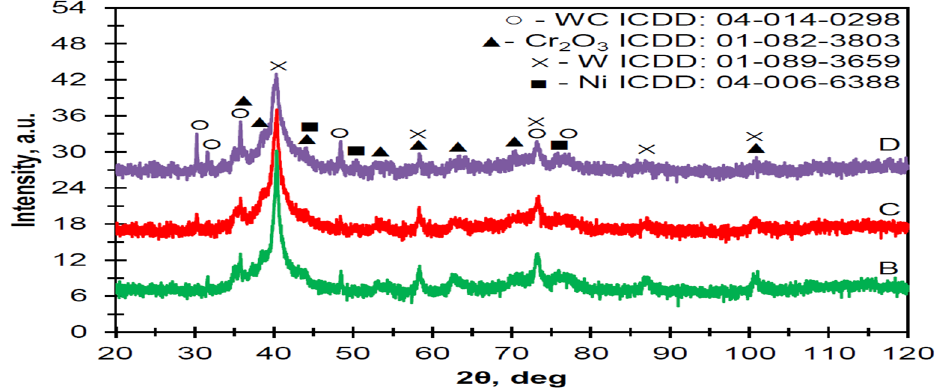
Figure 8. The XRD pattern of pure plasma-sprayed Thermico SJA 175 powder (B) with addition of 5 wt. % (C) and 10 wt. % (D) of YSZ powder.